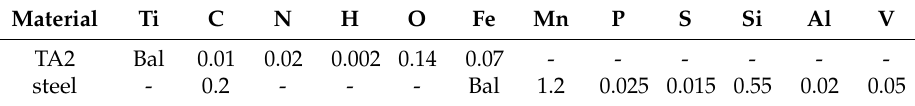
Table 1. Chemical composition in wt.% of pure Ti and substrate